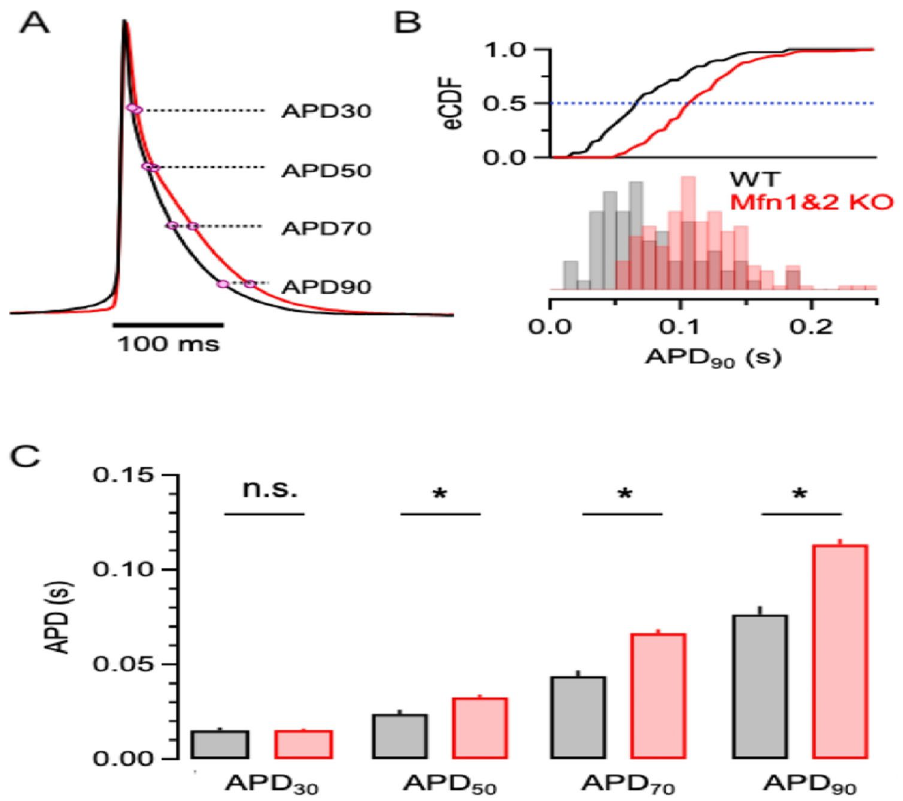
Figure 2. Functional characterization of isolated cardiomyocytes from mouse whole hearts using (OptioQUANT) platform. ( A ) Representative waveforms of action potential obtained from the wild-type (black trace) and Mfn1&2 KO (red traces) mouse cardiomyocytes. Dots represent AP points at 30%, 50%, 70% and 90% repolarization after depolarization. ( B ) Histograms (bottom) of wild type and mfn1&2 KO mouse cardiomyocytes show substantial variability and non-identical distribution of APD 90 . The empirical cumulative distribution plot (upper) shows prolonged action potential durations in the transgenic KO mouse cardiomyocytes. The blue dotted line illustrates median value. ( C ) Bar graph summarizing the APD at 30%, 50%, 70% and 90% of repolarization in WT (n = 77) and DKO (n = 152) cells. APD 30 : 0.015 ± 0.002 vs 0.015 ± 0.001; APD 50 : 0.024 ± 0.002 vs 0.033 ± 0.002; APD 70 : 0.044 ± 0.003 vs 0.066 ± 0.002 and APD 90 : 0.076 ± 0.004 vs 0.113 ± 0.003. All APD values in seconds. *p < 0.001 determined by Student’s t-test. *eCDF: empirical cumulative distribution function; APD action potential